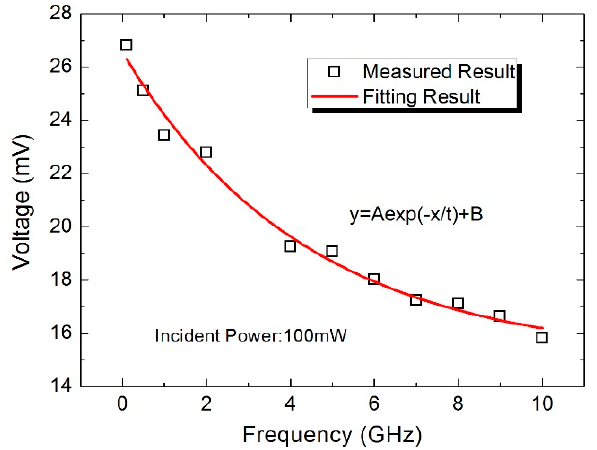
Figure 13. Measured voltage versus the frequency of the signal from 0.1 GHz to 10 GHz.